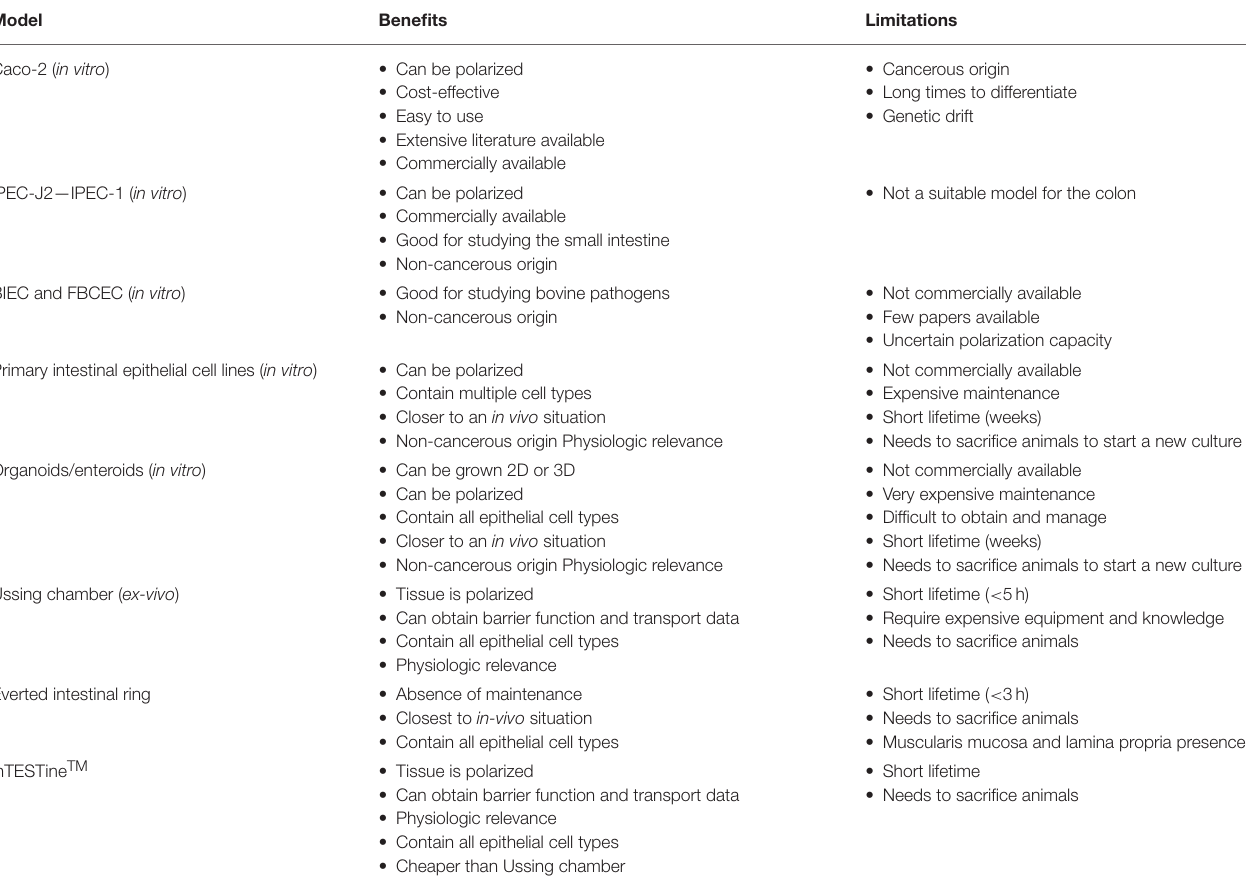
TABLE 1 | In vitro and ex vivo model benefits and